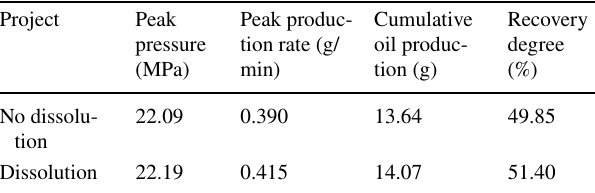
Fig. 14 Cumulative oil production curve contrasting dissolution and no dissolution (experiment 1) Table 6 Dissolution function parameters in the CO ery flooding process